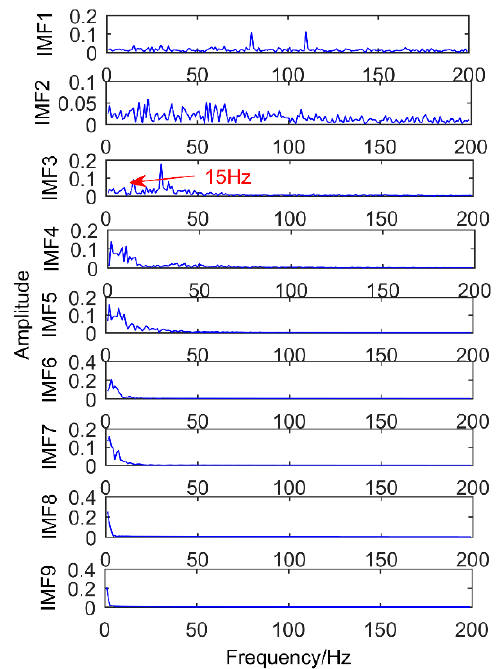
Figure 22. Envelope spectrum of the decomposition results obtained by EEMD.